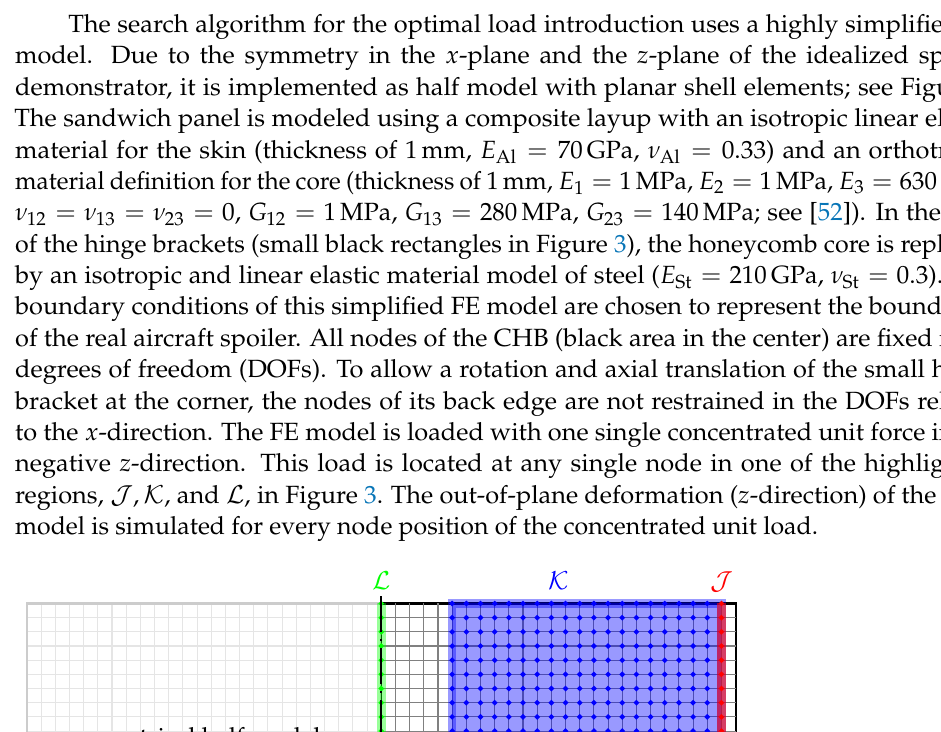
, , and . The 2D shell elements have J K L